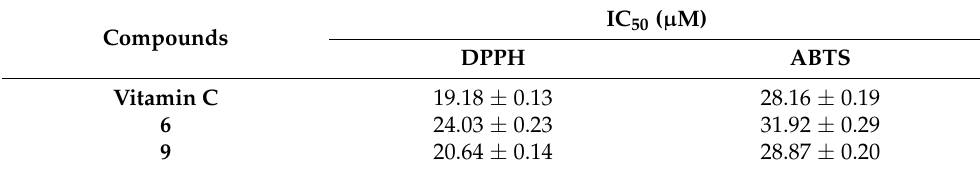
Table 4. The antioxidant properties of the OSe compounds using the DPPH and ABTS bioassays.